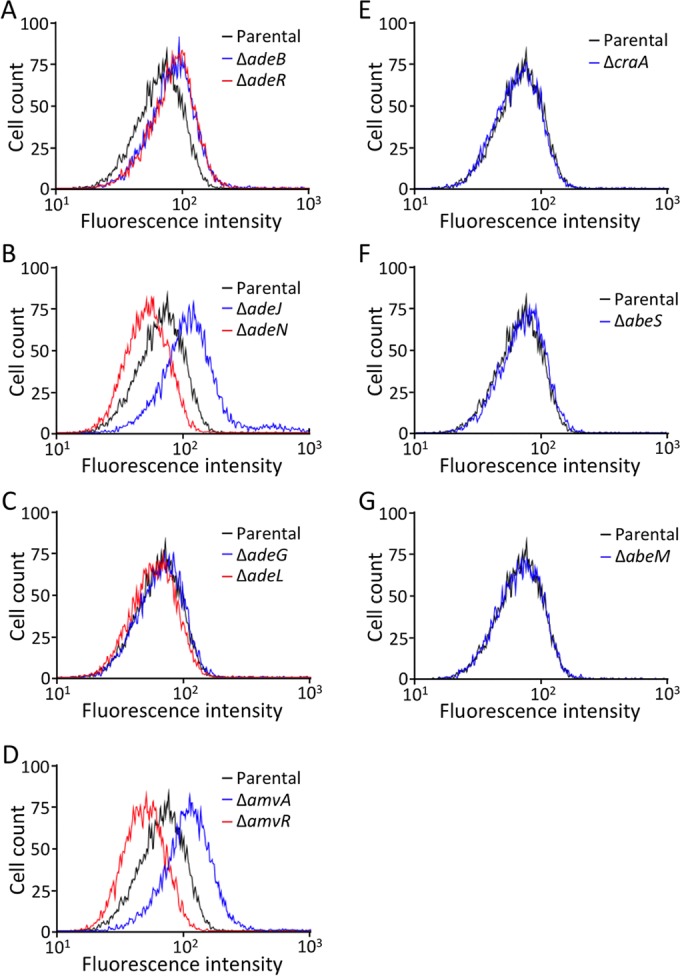
Flow cytometric analysis of Acinetobacter baumannii AB5075-UW parental strain (black), inactivated efflux pump mutants (blue), and inactivated efflux regulatory mutants (red). The fluorescence profile of the parental population is shown in all panels and is overlaid with the profiles of ΔadeB and ΔadeR (A), ΔadeJ and ΔadeN (B), ΔadeG and ΔadeL (C), ΔamvA and ΔamvR (D), ΔcraA (E), ΔabeS (F), and ΔabeM (G). Cell populations were exposed to 40 µM ethidium bromide, and each curve shows the fluorescence intensity for 10,000 cells. The cell populations show distinct fluorescence profiles based on the concentration of ethidium in the cell cytoplasm.